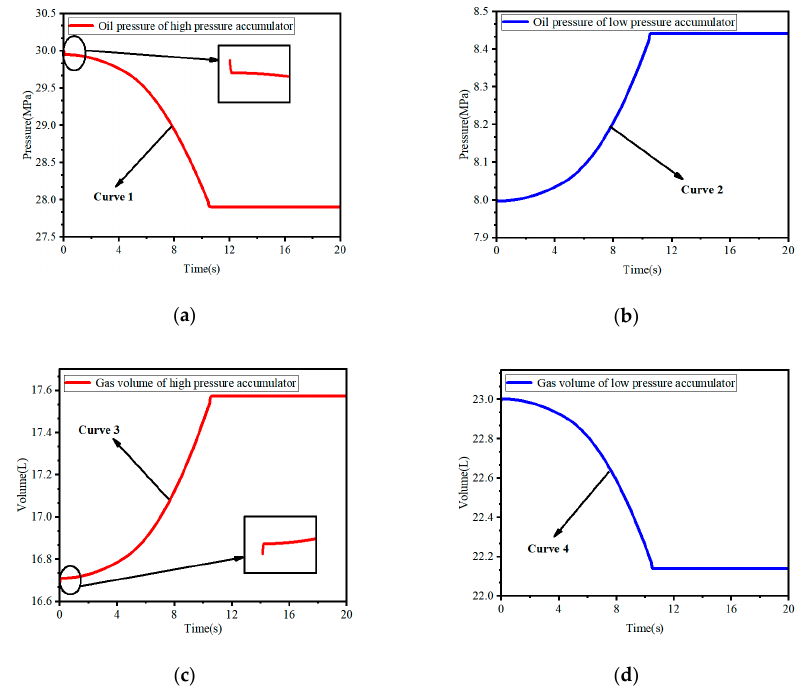
Figure 11. Diagrams of the pressure and gas changes of the accumulator. ( a ) is the curve of oil pressure in high pressure accumulator, ( b ) is the curve of oil pressure in low pressure accumulator, ( c ) is the curve of gas volume in high pressure accumulator, and ( d ) is the curve of gas volume in low pressure accumulator.